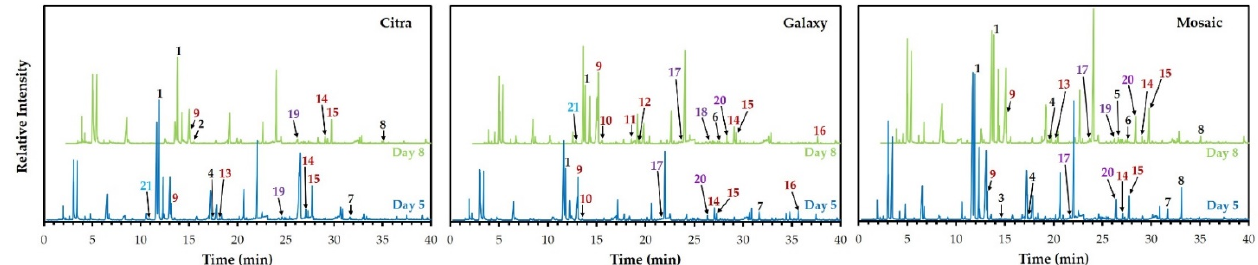
Figure 5. HS–SPME–GC–MS chromatograms are shown after 5 ( blue ) and 8 ( green ) days of dry hopping with three hop varieties (Citra, Galaxy, and Mosaic). Select VOCs that originated from the hops and were consistently detected across samples are numbered here. Terpenes are in black 1–8 (1: β -